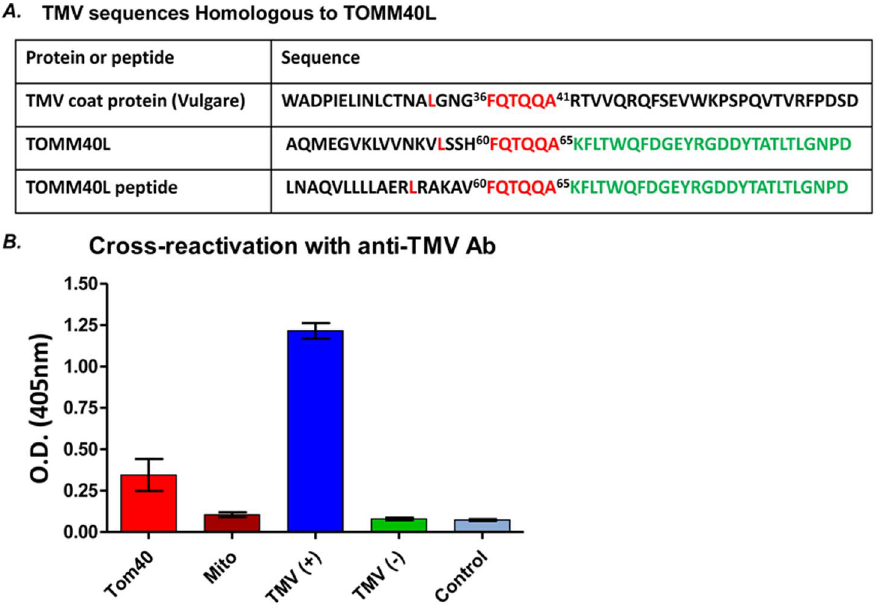
Figure 3. Cross reactivity between TMV and TOMM40L. (A) Sequence homology comparison among TMV-Vulgare coat protein. Basic Local Alignment Search Tool (BLAST) indicated the regions of local sequence similarity (color red) among TMV and TOMM40L gene and TOMM40L peptide; and sequence similarity (color green) between TOMM40L gene and peptide. (B) Cross-reactivity of anti-TMV antibodies and TOMM40L peptide determined by tobacco mosaic virus PathoScreen ELISA kit. Data are representative of two independent experiments with similar results. Results were expressed as O.D. values (mean 6 SE, triple wells per group). Tom40 = TOMM40L peptide, Mito = crude mitochondria pellet, TMV ( + ) = TMV- infected tobacco leaf, TMV (-) = TMV-negative alstroemeria leaf, and control = ELISA assay